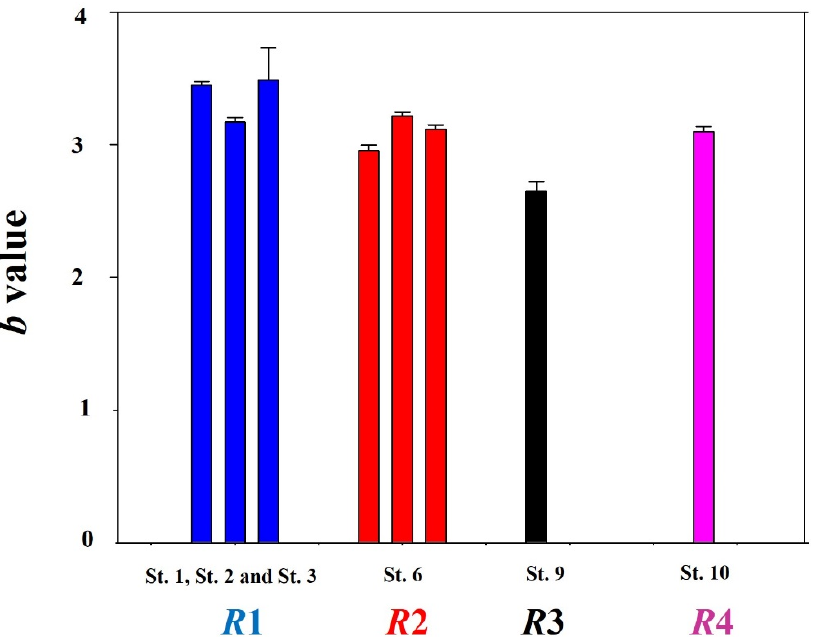
Figure 3. Regional b values for chum salmon ( Oncorhynchus keta ) individuals that migrated to South Korea from 2018 to 2020. Unlike Figure 2, the R 1 region showed the greatest b value among four regions, while R 3 showed the smallest value (n = 422 for St. 1; 11 for St. 2; 18 for St. 3; 258 for St. 6 in